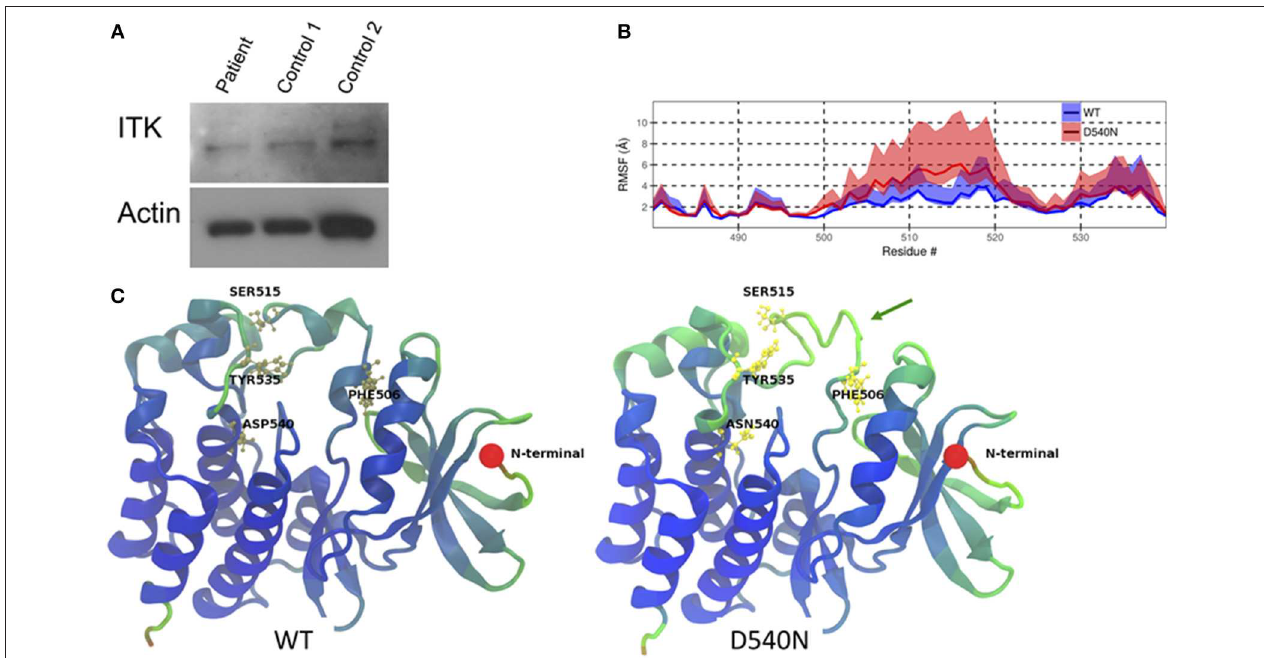
FIGURE 1 | ITK mutation in the patient. (A) ITK protein is present in the patient’s peripheral blood mononuclear cells at a similar level to control. Actin is a protein loading control. (B) The root mean square fluctuation (RMSF) for wild-type ITK (WT) and the mutant ITK in the patient (D540N) is shown with the 80% confidence interval highlighted. (C) Average structure from the simulations, displaying the increased flexibility of the ITK kinase domain, which causes the alpha helical turns in residues 504–506 and residues 510 to 513 to be missing from the mutant compared to the WT ITK, indicated by the green arrow. The residues are colored according to their RMSF values, with blue representing low-, green representing the mid- and red representing the high-RMSF values.